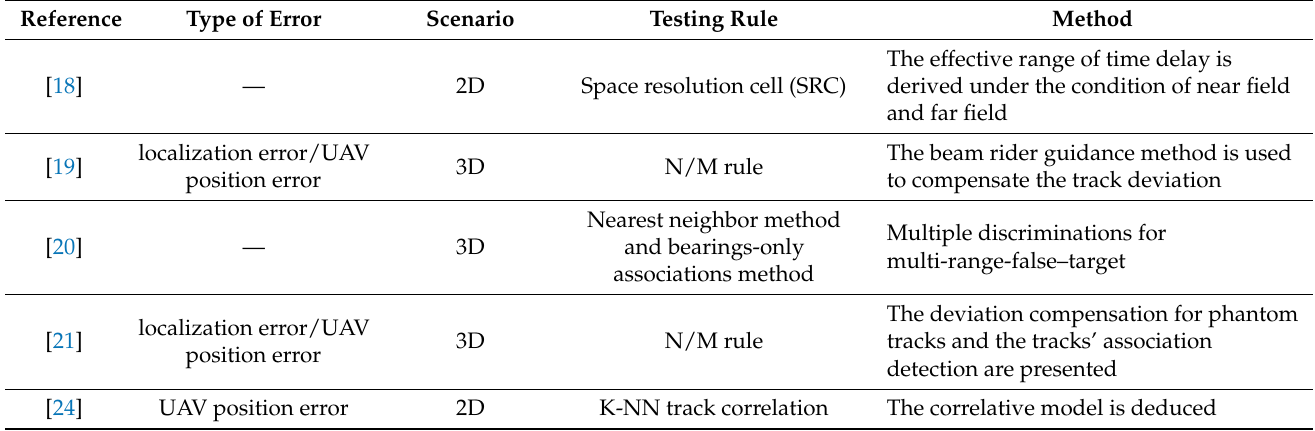
Table 4. Related work by Chinese